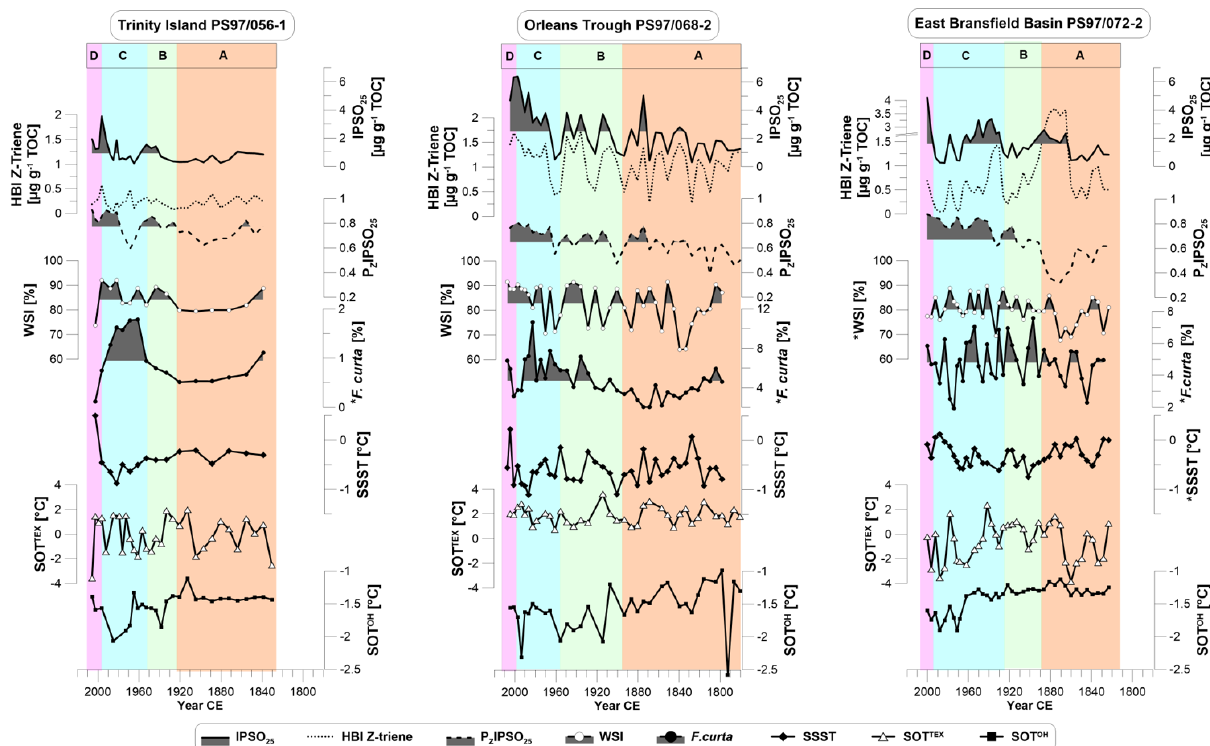
Figure 3. Biomarker composition of the three sediment cores showing concentrations of (from top to bottom) IPSO 25 and HBI Z-trienes, the sea ice index P Z IPSO 25 , diatom-derived winter sea ice (WSI) concentrations, abundance of F. curta , summer sea surface temperatures (SSSTs), subsurface ocean temperature derived from TEX L (SOT TEX ), and OH-GDGTs (SOT OH ). Data marked with * are from the trigger 86 core PS97/072-1. Vertical colored bars denote the environmental units A to D described in Sect. 4.5. The shading marks values above the mean of each biomarker in the respective